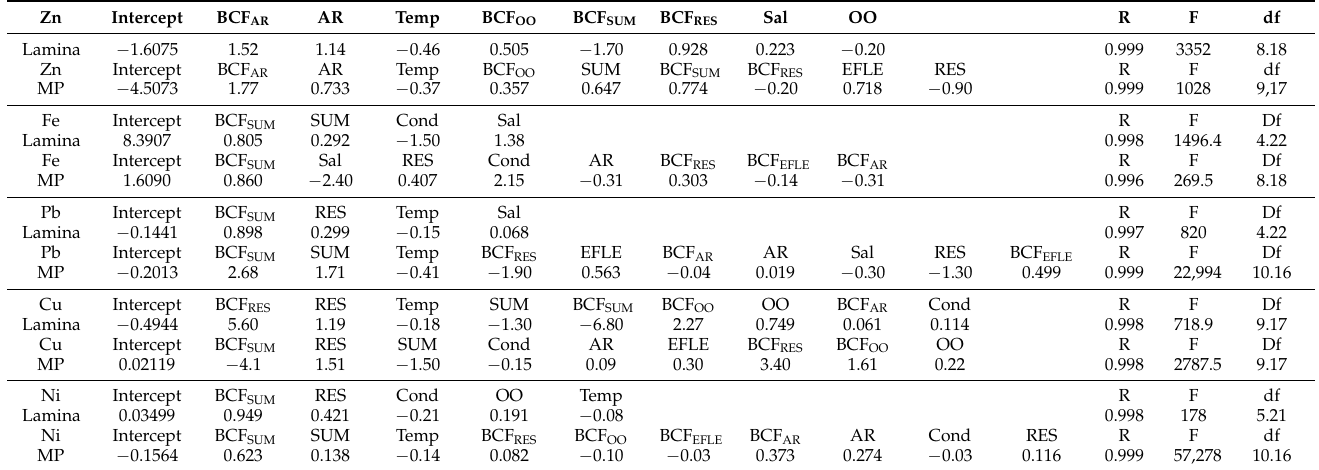
Table 11. Multiple linear stepwise regression analytical outputs based on Rhizophora leaves (lamina (L); midrib plus petiole (M)), as dependent variables and independent variables, are the bioconcentration factors, sedimentary geochemical fractions, and surface water